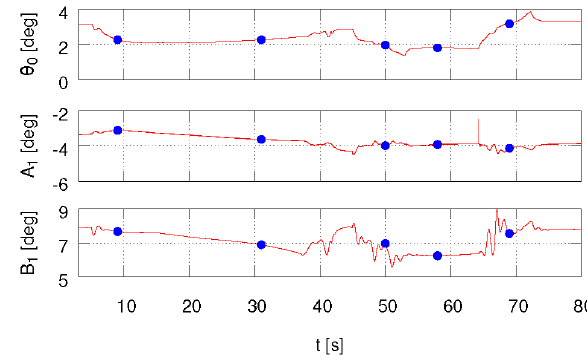
Figure 3: Main rotor TPP-AOA time history in maneuver ID8021.